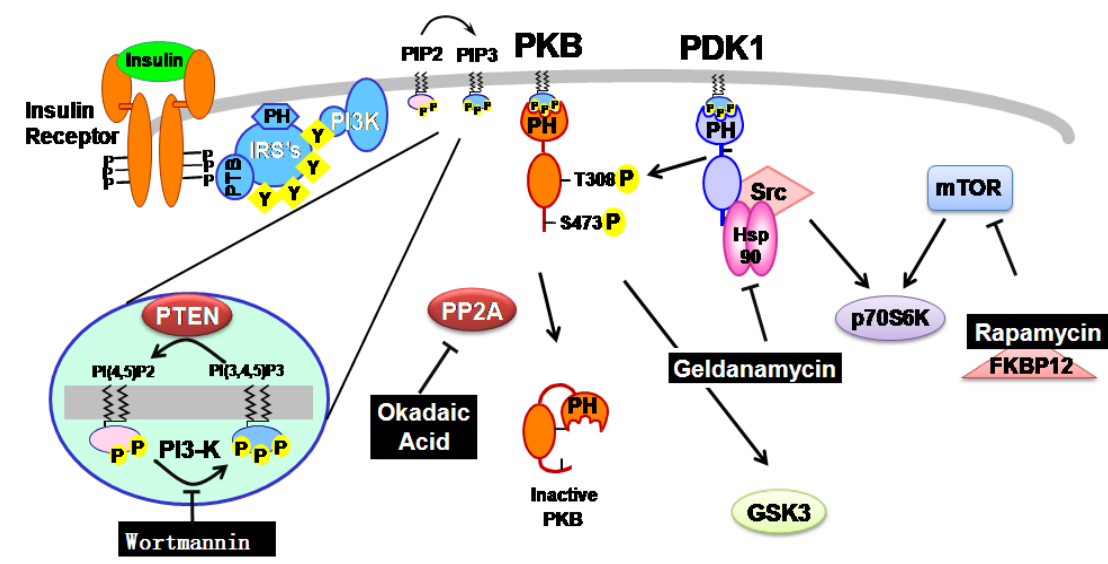
Figure 2. Inhibition of each signaling molecules by natural products in insulin